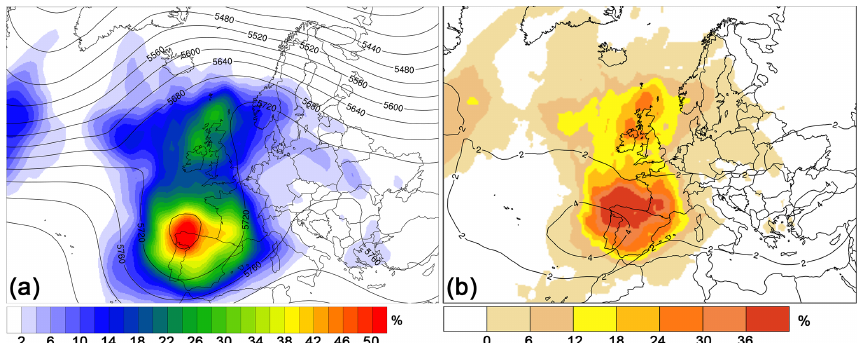
Figure 10. (a) Composite mean of 500hPa geopotential height (contours every 40gpm) and cut-off low frequency (colour shading in %) during the study period. (b) Climatological mean percentage of days with a cut-off low in May and June (black contours; every 2% for May and June 1981–2010) and anomaly percentage of days during the study period (shaded in % with reference to mean percentage of days in May and June, both based on ERA-Interim).